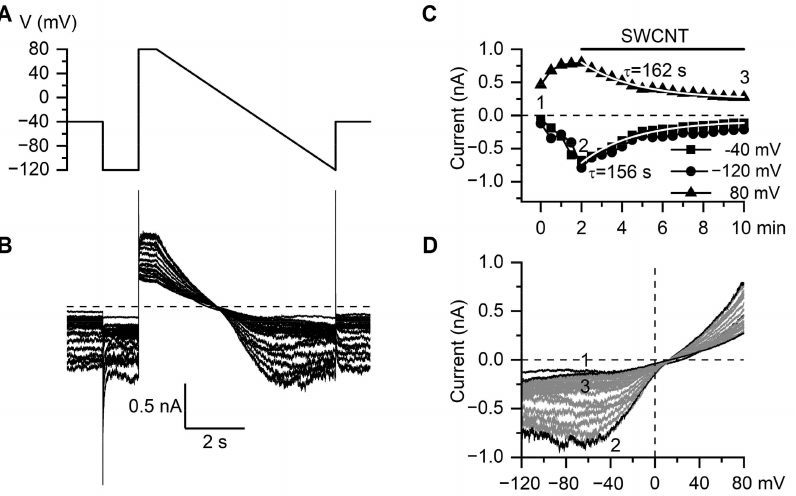
Figure 7. SWCNTs inhibit the muscarinic cation current via TRPC4 channels. ( A ) Voltage protocol and ( B ) corresponding representative superimposed current traces of the cationic current activated by GTP γ S infusion and then suppressed by SWCNTs. ( C ) Time course of mI CAT development in response to GTP γ S followed by its time-dependent inhibition as assessed at three different test potentials ( − 40, − 120 and 80 mV). Superimposed white lines show that, after SWCNT application, mI CAT mono-exponentially declined with similar time constants both at negative and positive potentials. ( D ) Corresponding superimposed current–voltage relations of mI CAT measured by the slow (6 s duration) voltage ramp from 80 to − 120 mV ( A ). Shown in black are three I-V curves measured immediately after membrane break-through ( A ), at the peak response to GTP γ S ( B ) and at the steady-state current inhibition by SWCNTs ( C ), as indicated by the same letters in panel ( C